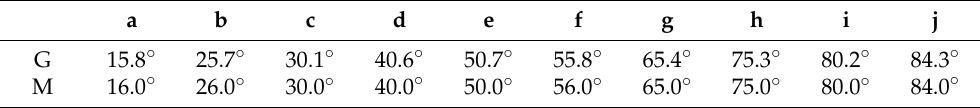
Table 3. Data of the cross-section.